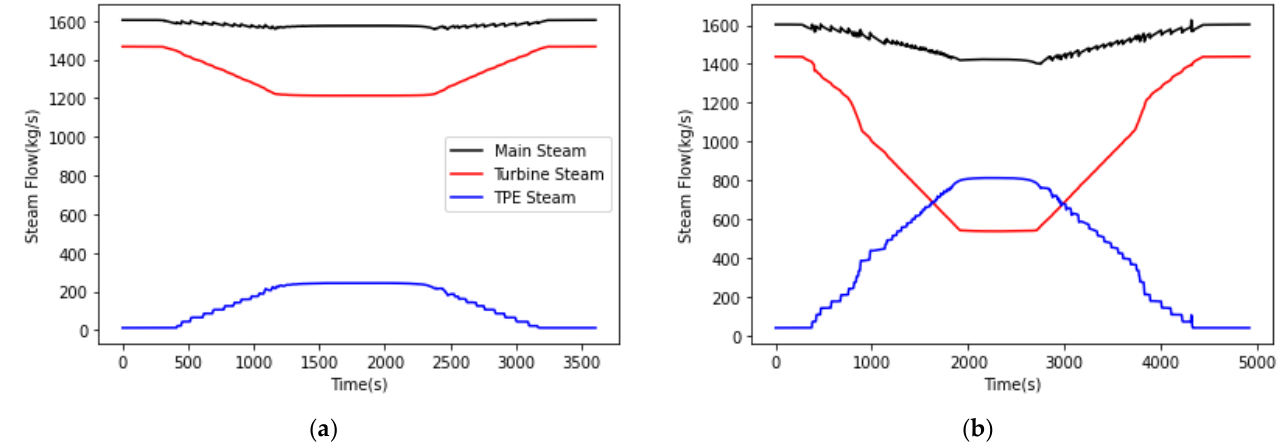
Figure 3. Steam flows, including main steam flow, steam flow to the TPE, and steam flow to the turbine, during the transitions between pure electric power generation and mixed-mode power generation. Results are shown for 15% TPE ( a ) and 50% TPE ( b ).